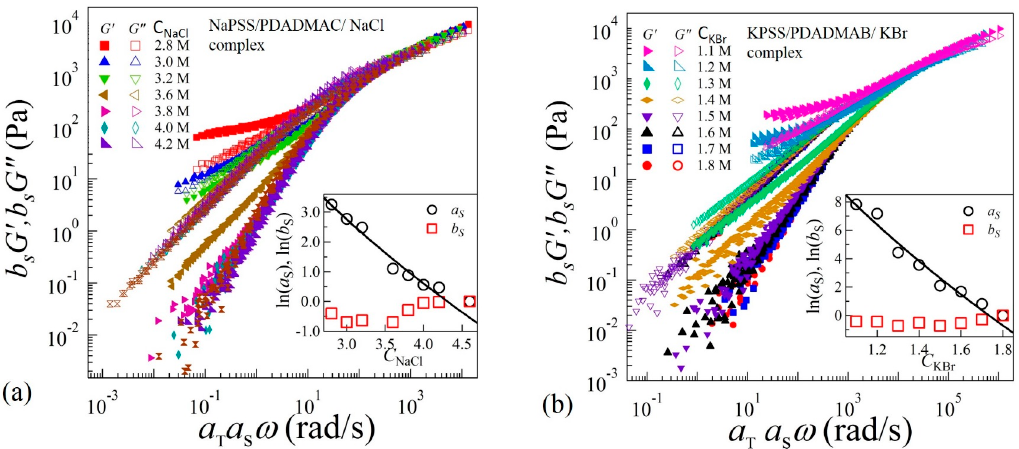
Figure 4. Time-temperature-salt superposition of frequency sweep data acquired in complex coacervates in the presence of ( a ) NaCl at reduced salt concentration (cid:1829) (cid:2898)(cid:2911)(cid:2887)(cid:2922)(cid:3045) = 4.6 M and ( b ) KBr at reduced salt concentration (cid:1829) (cid:2895)(cid:2886)(cid:2928)(cid:3045) = 1.8 M . The insets show plot of the shift factors (cid:1853) (cid:2929) and (cid:1854) (cid:2929) as functions of salt concentrations. The solid lines are fit to Equation (3).